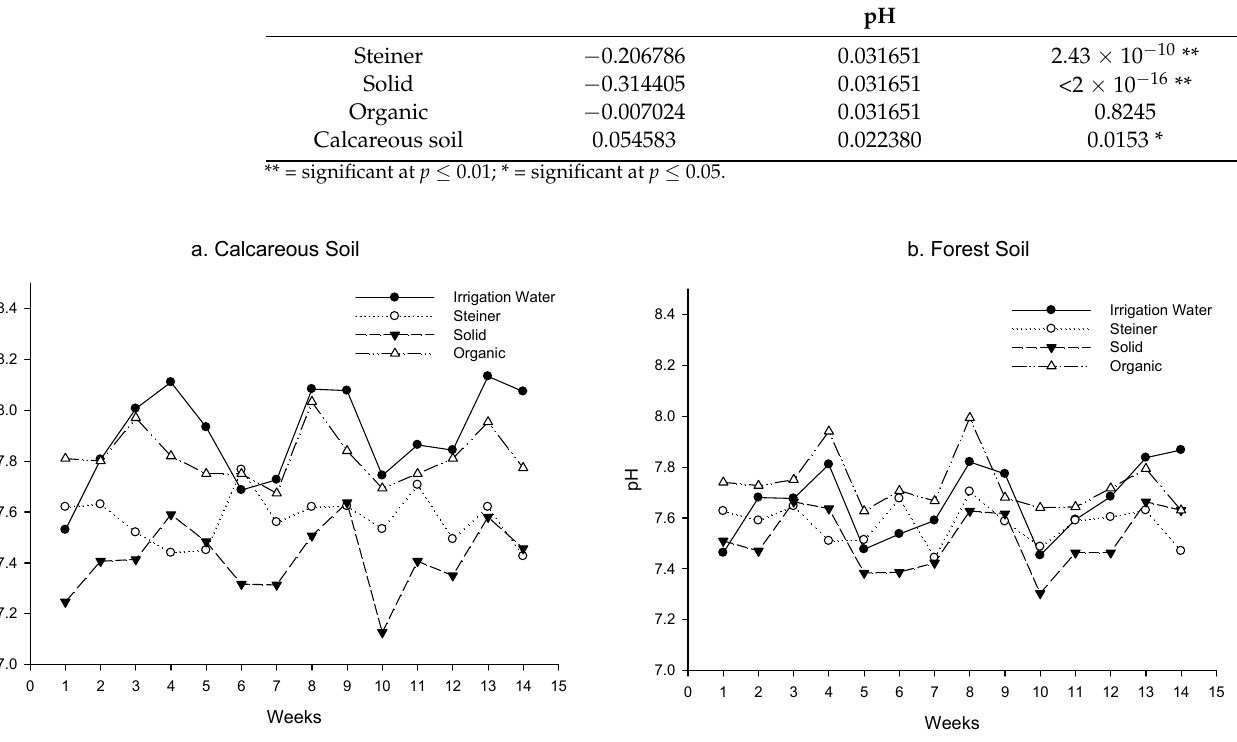
Table 6. Multiple linear model between pH and two explanatory variables (treatment and soil type). The reference treatment for the comparison of the different nutrient contribution scenarios was irrigation water, while the forest soil was used as a reference to compare it against the calcareous soil. Variables